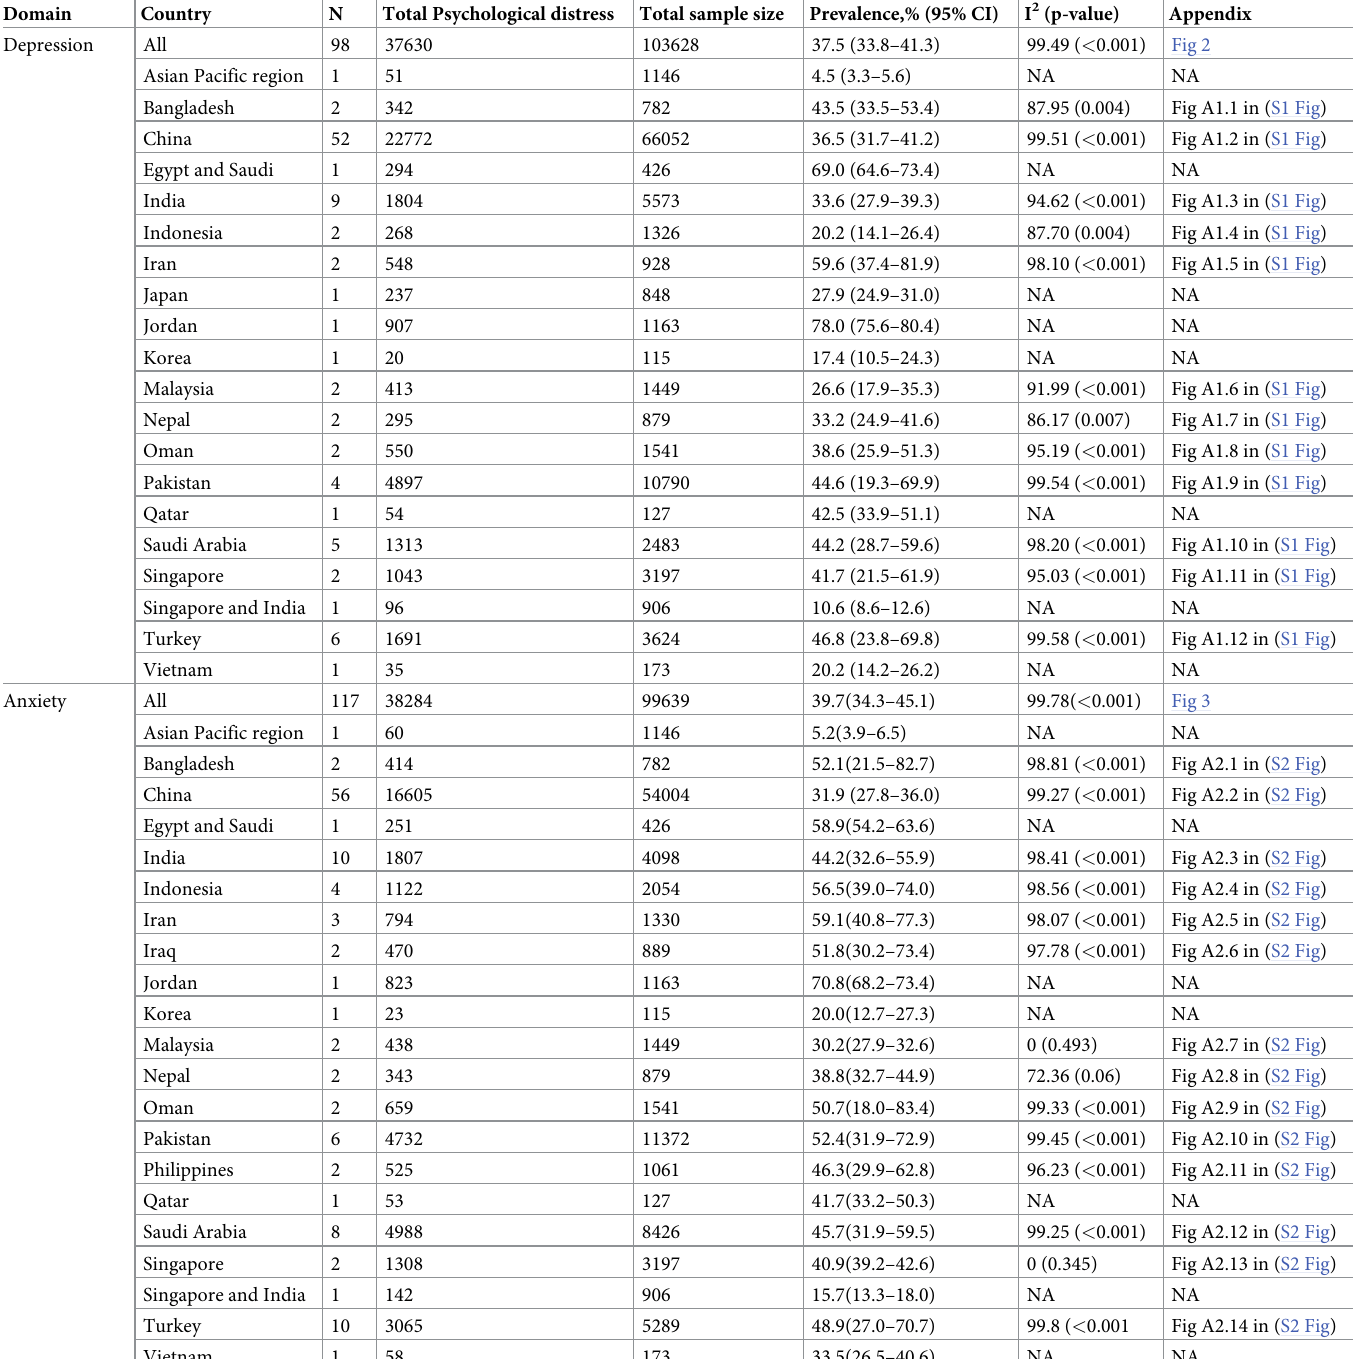
Table 2. Summary of pooled prevalence of psychological distress among healthcare providers during COVID-19 pandemic.